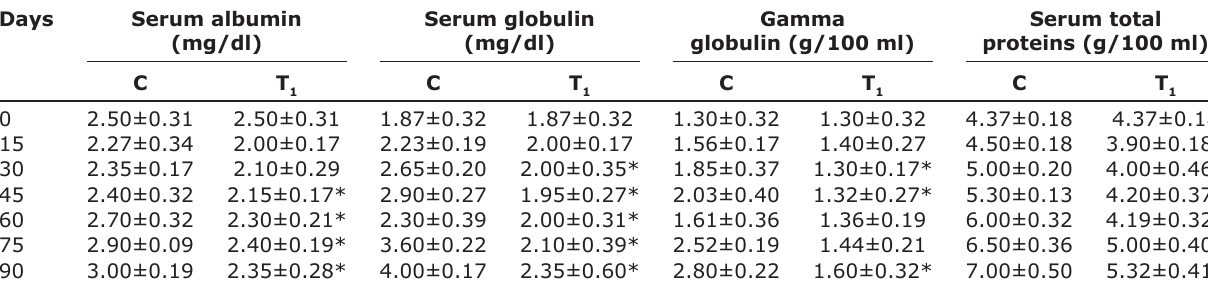
Table-3: Effect of CPF (mean±SE) on serum proteins in layers. Days